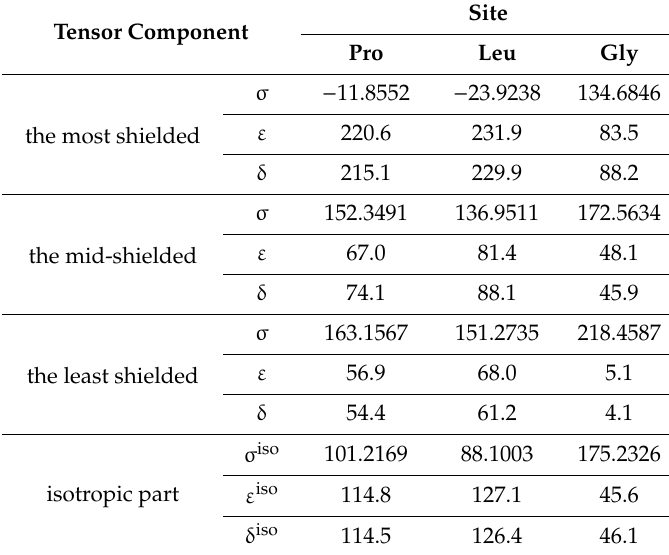
Table 2. The chemical shift / shielding tensor data (in ppm) of the 15 N amid nuclei in melanostatin. The σ values are taken from the CASTEP output, ε values are obtained from the parametrization as described in the text, and δ values are from the experiment [17].